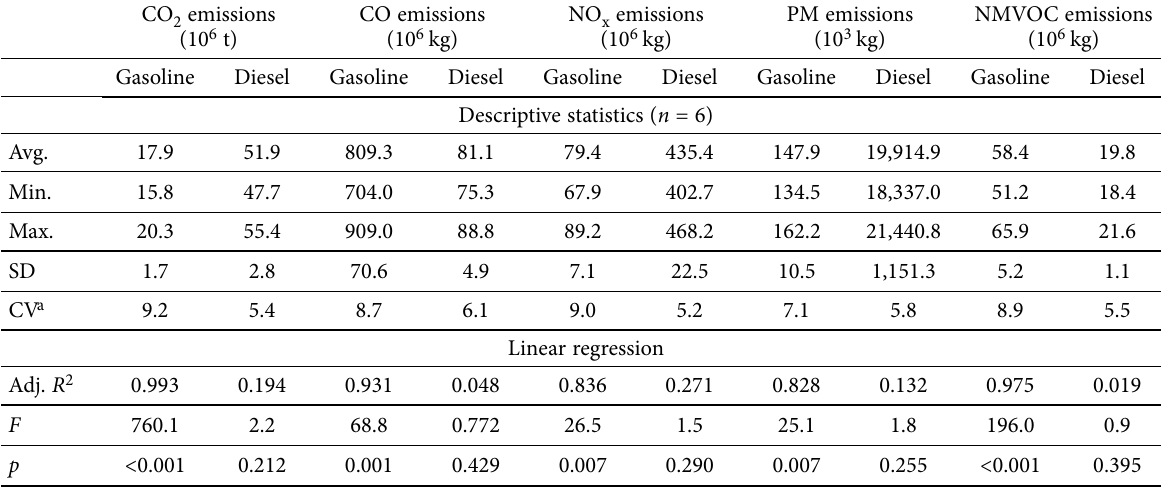
Table 4. Summary of linear trend analysis for Spanish interurban road transport emissions from 2004–2009 (source: this